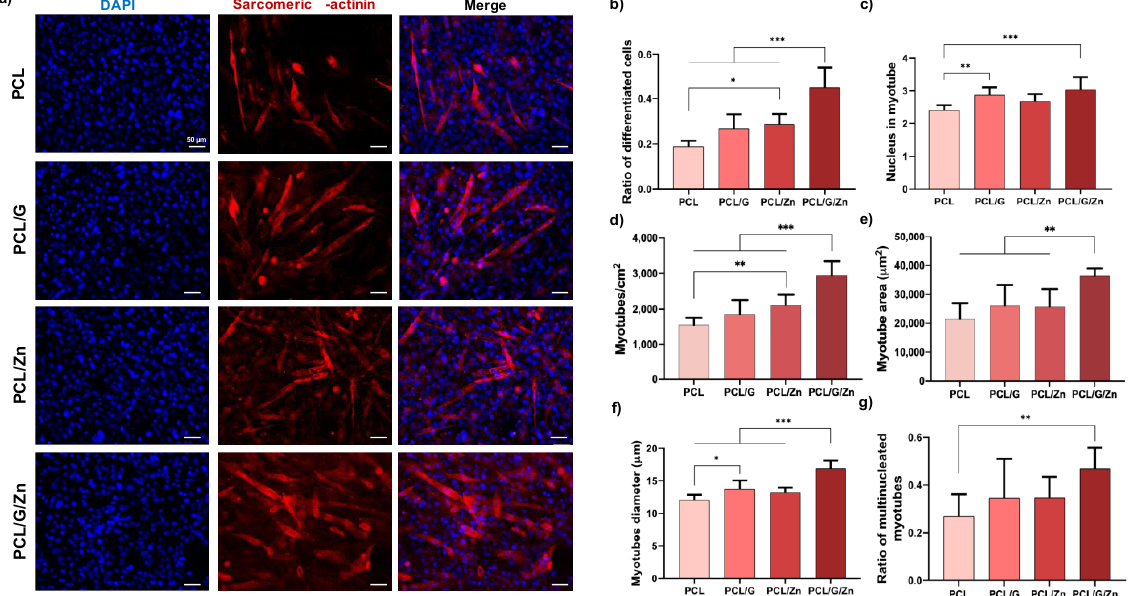
Figure 6. Myoblast differentiation in differentiation medium (DMEM +1% ITS +1% P/S. ( a ) Immunofluorescence images of differentiated myoblasts (sarcomeric α -actinin staining) after 3 days of culture; ( b ) Ratio of differentiated cells relative to initial cell density; ( c ) Average number of nuclei inside myotubes; ( d ) Myotube density; ( e ) Myotube area; ( f ) Myotube diameter analysis of 80 random myotubes per condition; ( g ) Ratio of multinucleated myotubes. Graphs show mean ± standard deviation. (*), (**) and (***) indicate significant differences ( p < 0.05, p < 0.01, and p < 0.001, respectively).